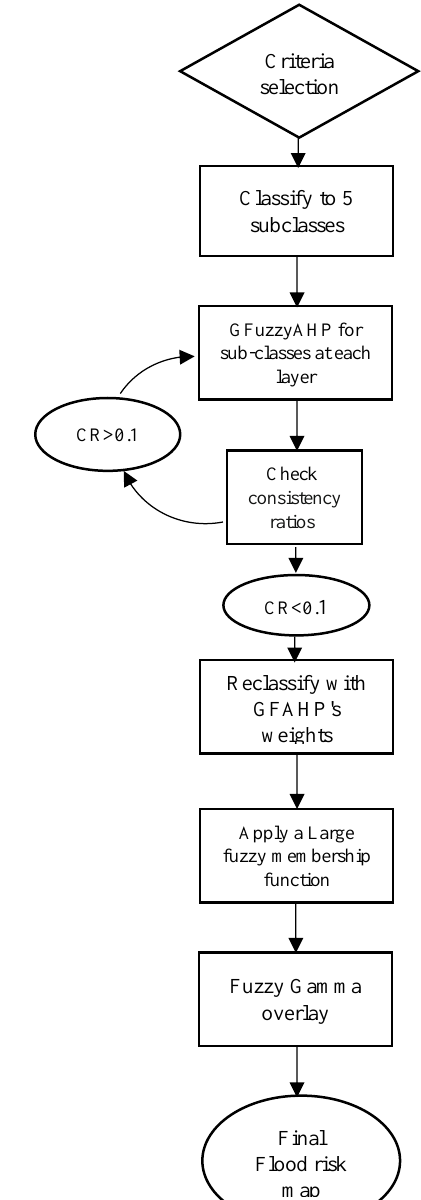
Figure 2. Flowchart of the proposed